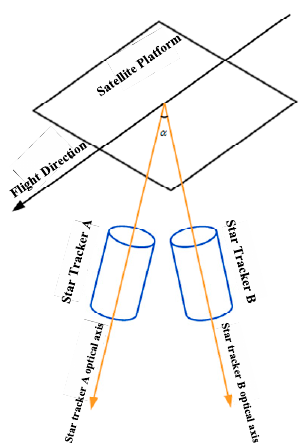
Figure 1. Star tracker schematic diagram.